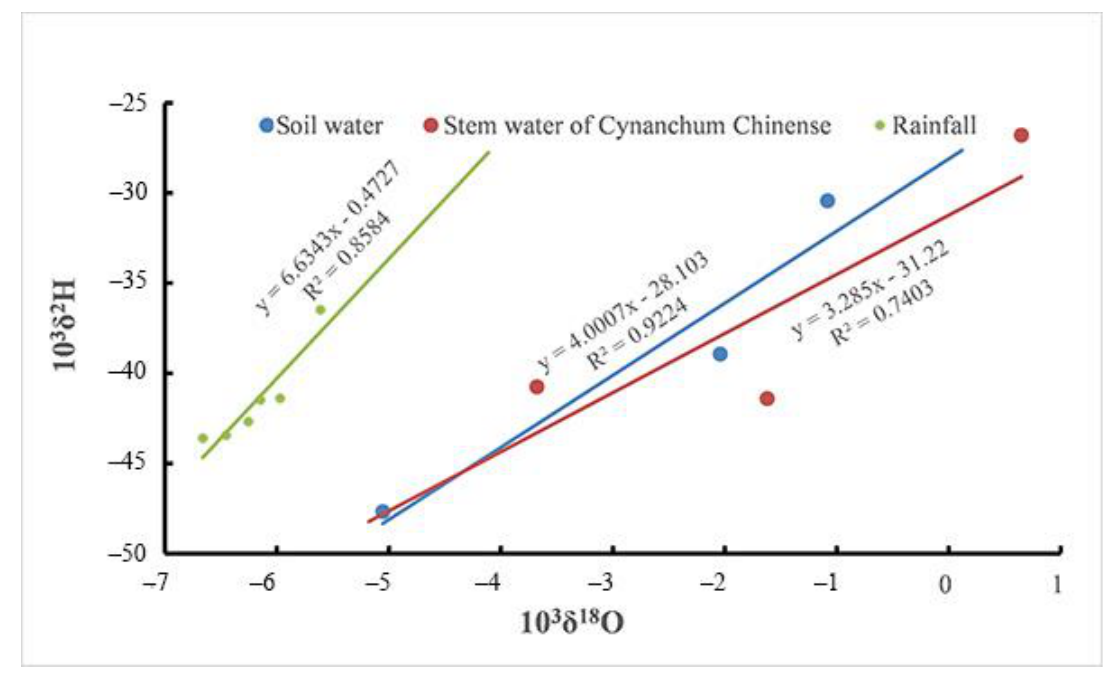
Figure 2. The relationships between δ 18 O and δD (regression equations as well as coefficients of determination (R 2 ) included) of rainfall (light green), soil water (blue), and the xylem water (red) in Cynanchum sibiricum. The values for soil water represent the values averaged from surface to a depth of 70 cm.